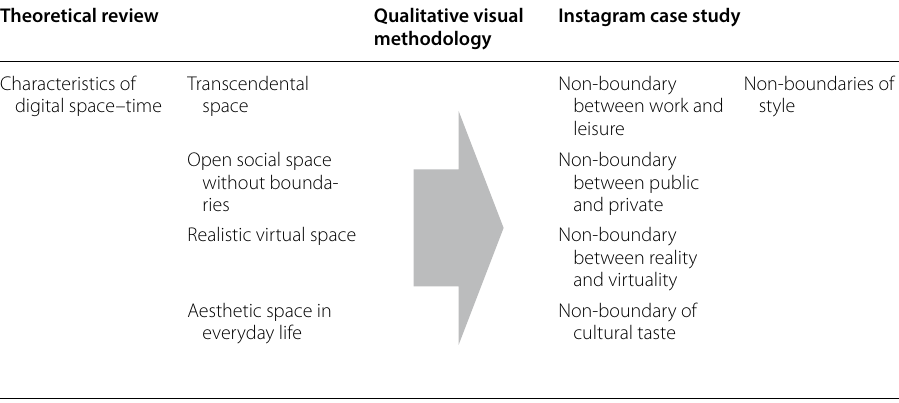
Table 2 Characteristics of digital space–time and non-boundaries of